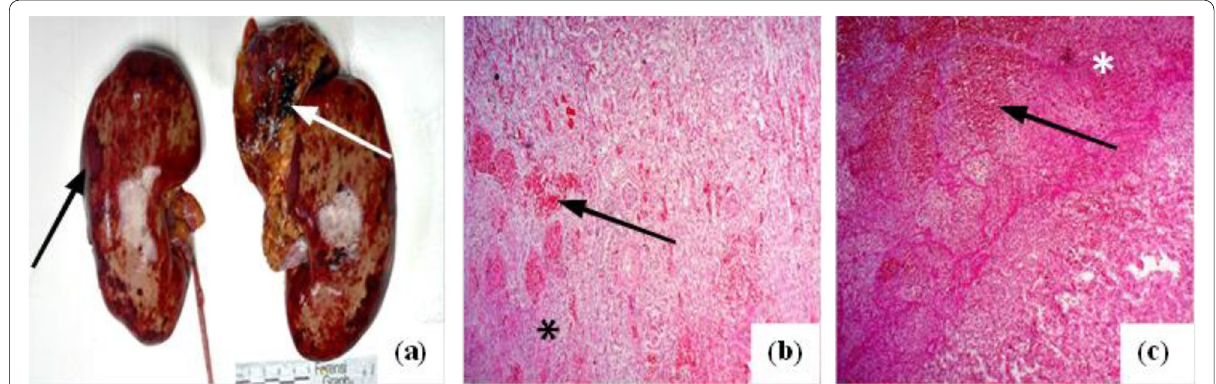
Fig. 2 The kidneys ( a ) and microphotographs H & E ( 4) of the kidney ( b ), and adrenal gland ( c ). The kidneys are edematous with cortical necrosis × and hemorrhages indicated with a black arrow. Left suprarenal mass is pointed with a white arrow ( a ). Microphotograph of renal parenchyma showing gross cortical necrosis indicated with an asterisk and thrombosed vessels by the black arrow, no calcium crystals within the tubules ( b ). Microphotograph of adrenal gland showing massive hemorrhage by black arrow and necrosis of the gland in white asterisk ( c )